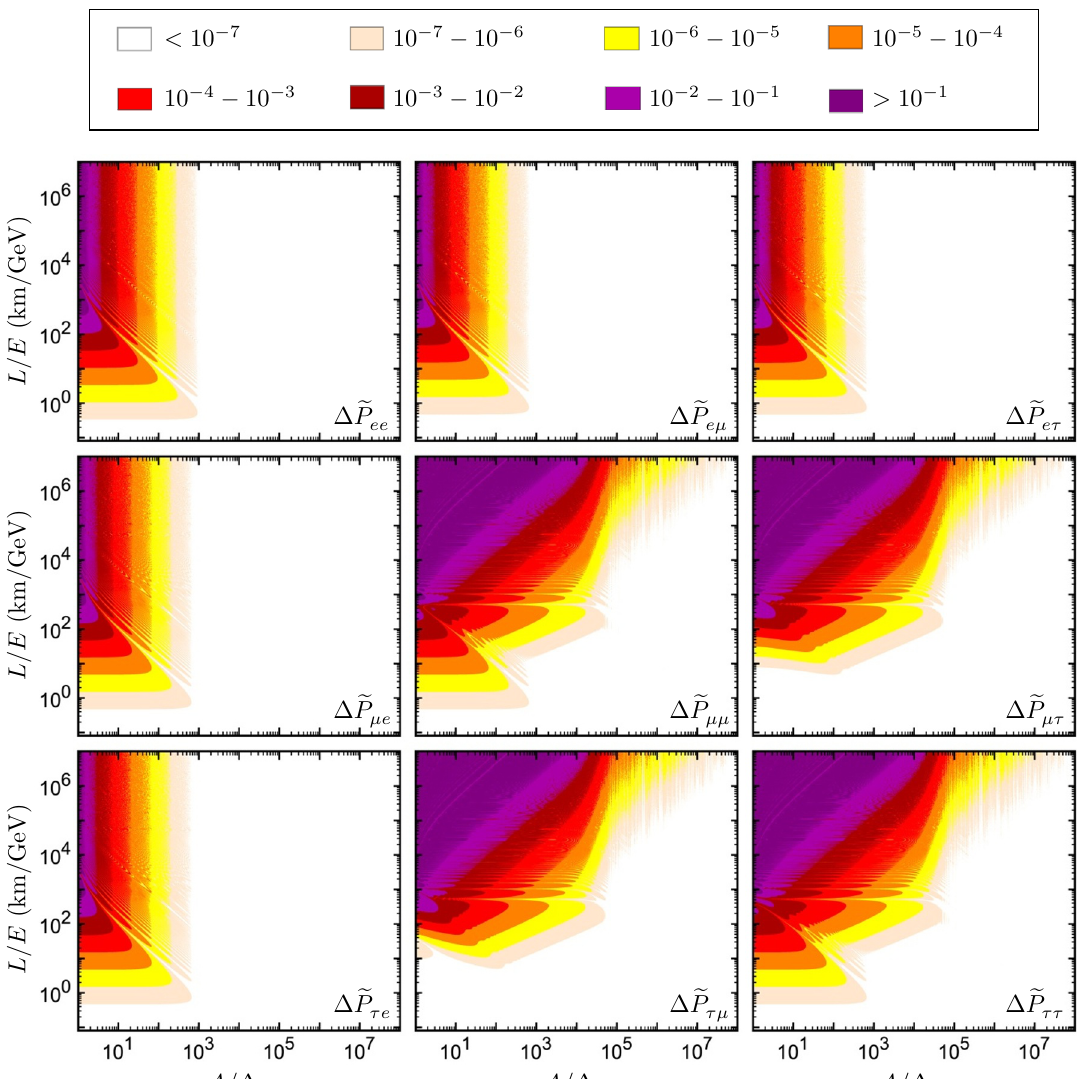
Figure 3 . The absolute errors of our analytical approximations in eq. (2.18), where the best-(cid:12)t values of ( (cid:18) ; (cid:18) ; (cid:18) ; (cid:14); (cid:1) ; (cid:1) ) in ref. [36, 37] and (cid:15) 12 13 23 21 31